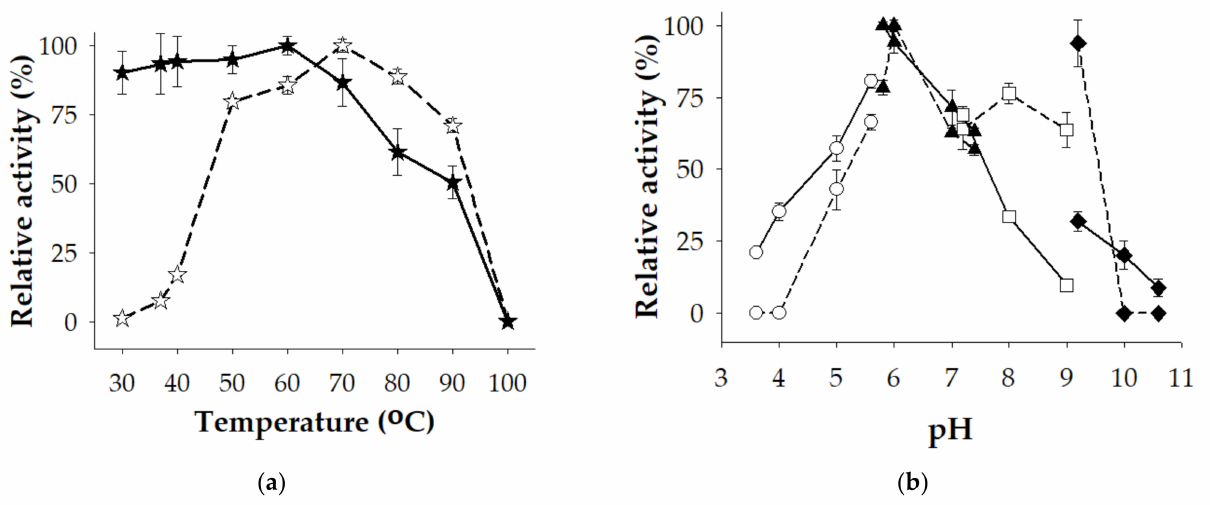
Figure 4. Effect of temperature ( a ) and pH ( b ) on the activity (dash line) and stability (solid line) of Streptomyces speibonae TKU048 ′ s crude-enzyme cocktail. ( ), optimal temperature; ( ), thermal stability; ( ), acetate buffer (pH = 3.6–5.6); ( ), phosphate buffer (5.8–7.4); ( ), Tris-HCl buffer (pH = 7.2–9.0); ( ), bicarbonate buffer (pH = 9.2–10.6). All data points are means ± S.D. of three different experiments (each experiment was conducted in triplicate). Maximal protease activity was set as 100% relative activity.